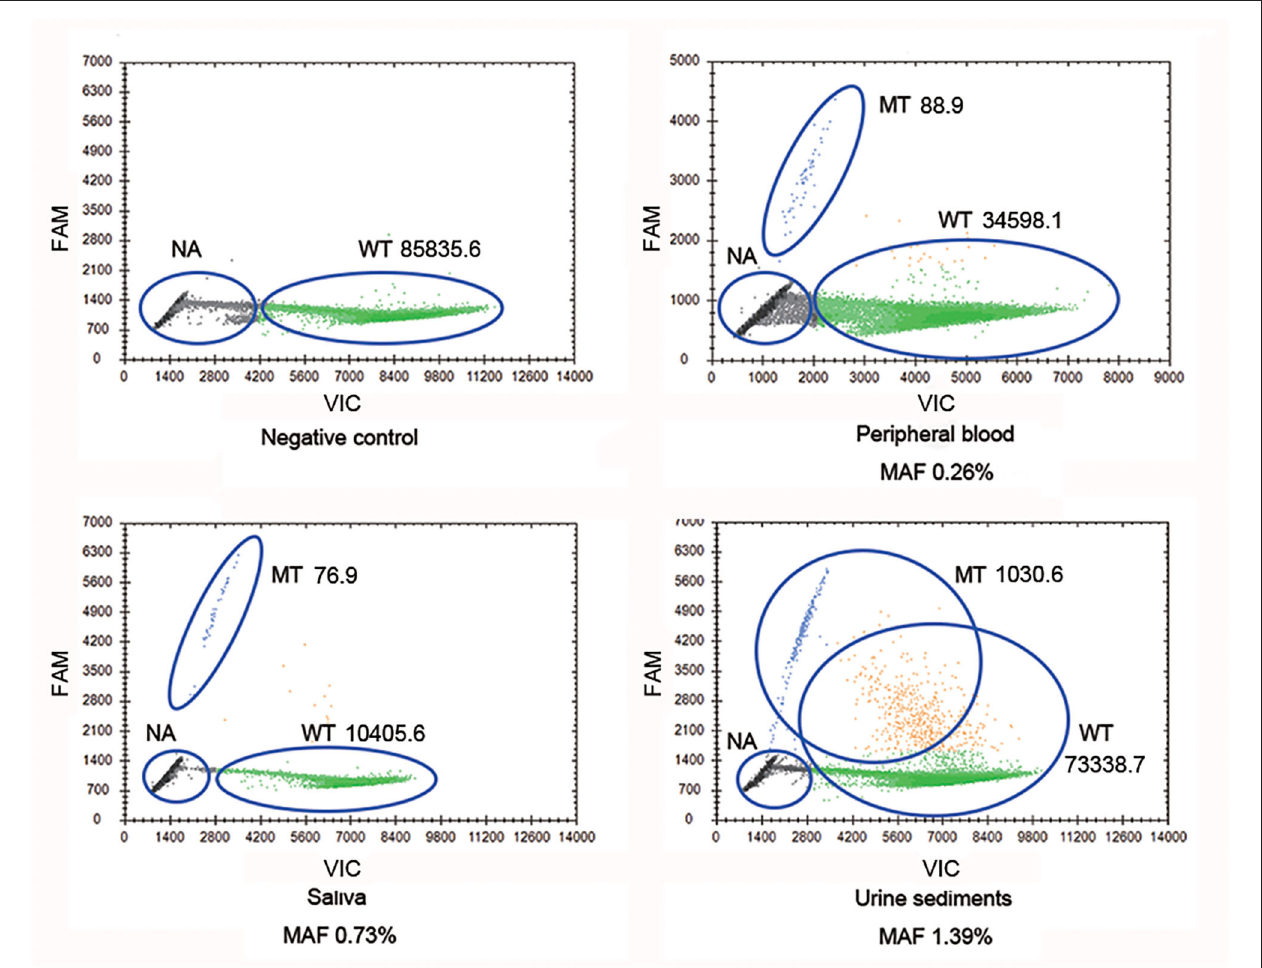
FIGURE 2 | COL4A5 wild-type and mutant-type (c.2245-1G > A) alleles were identified in multiple samples (blood, saliva, and urine sediments) from proband’s mother by droplet digital PCR (ddPCR). WT signals are from droplets containing wild-type alleles, MT signals are from droplets containing mutant alleles, NA signals are from droplets that did not contain target sequences, thus could not be amplified. WT, wild type; MT, mutant type; NA, not available.